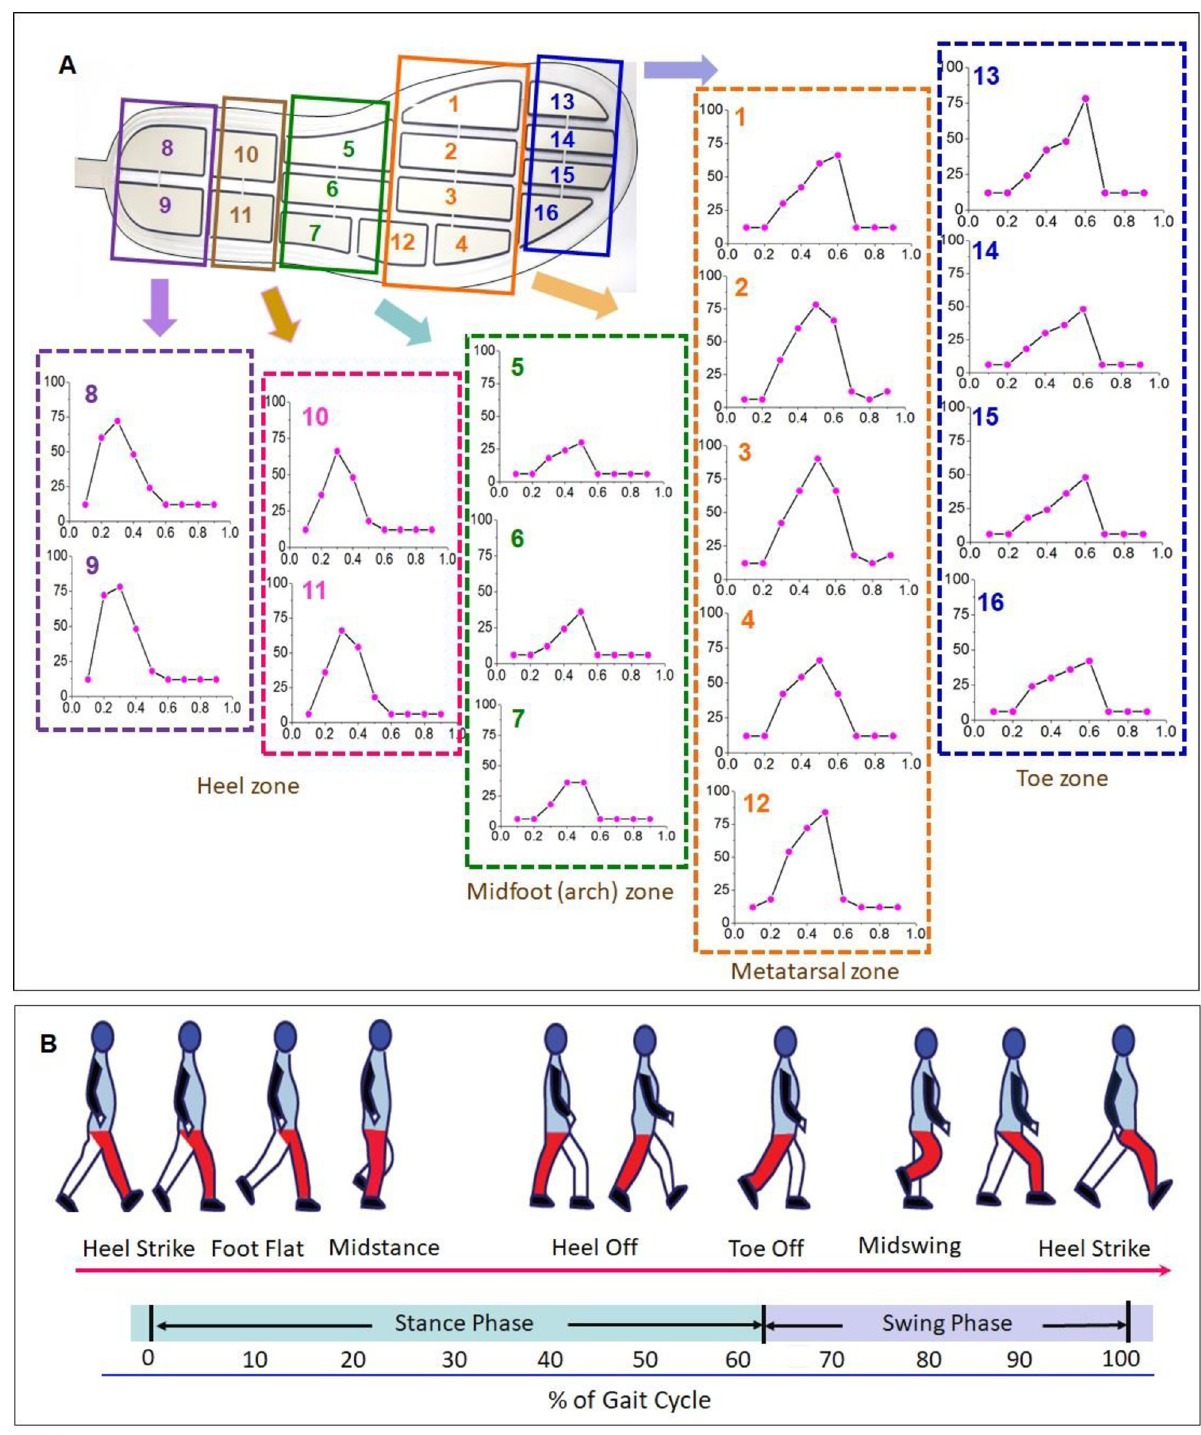
Fig 6. Plantar pressure force variations of the tested 16 sensor cells under a normal gait cycle (X-axis: Time (s), Y-axis: Force (N). Along the x- axis, 0s-0.2s indicate the stage of the heel-strike; 0.2s-0.4s indicate the stages of the foot-flat, 0.4s-0.5s indicate the stage of the midstance, 0.5s-0.6s indicates the stage of the heel-off, 0.6s-0.65s indicates the stage of the toe-off, and 0.6s-1s indicate the stage of the midswing).